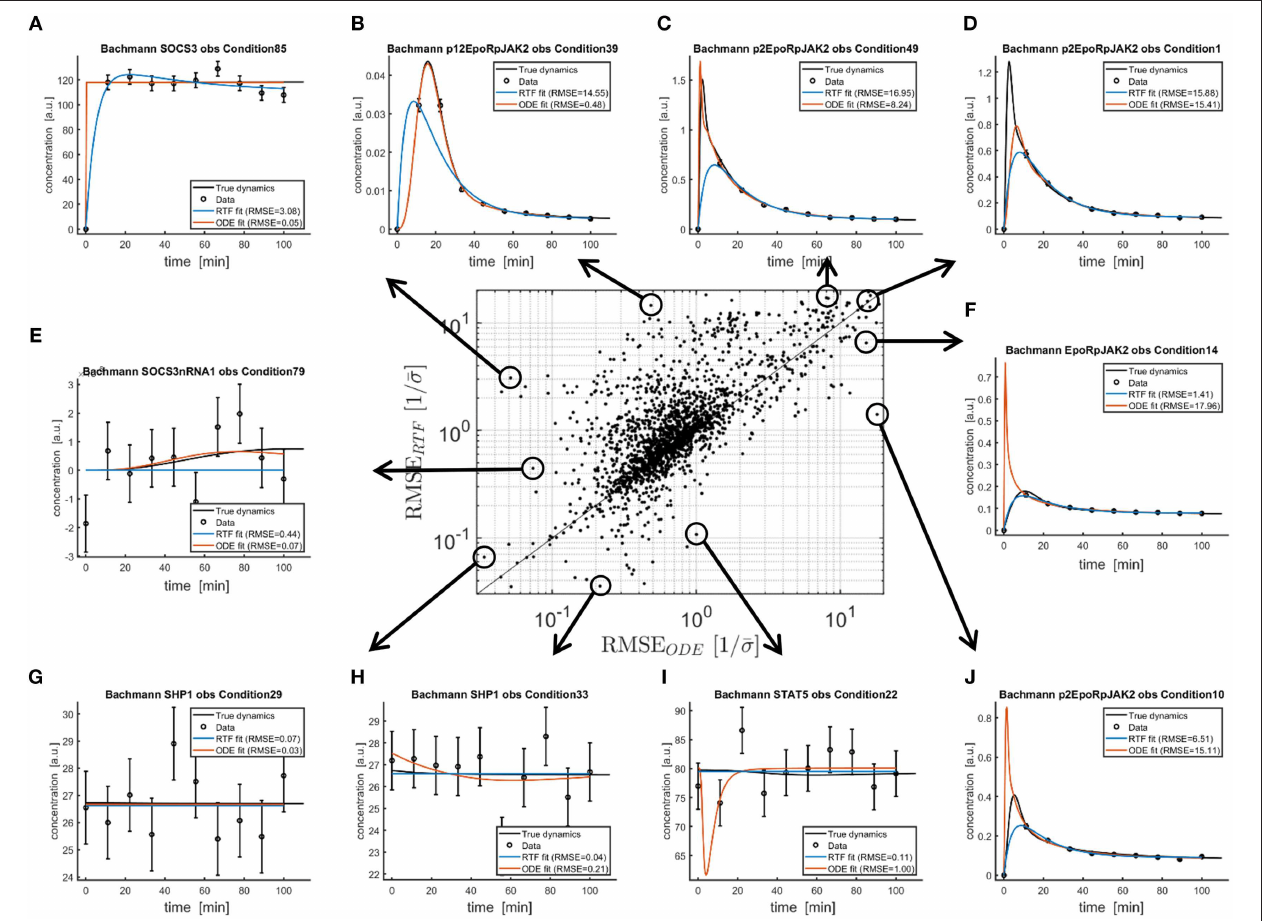
FIGURE 4 | Comparison of both, the fitted RTFs (11), (12) and the fitted ODEs from Bachmann et al. [29] to simulated data with published parameter values. Again, fitting has been performed based on (13), (18)–(21). The scatterplot in the middle shows RMSEs (14) between fitted and true dynamics (black lines) for both modeling approaches. For all points above the diagonal, the ODE model outperforms the RTF. However, there are also several examples where the RTF result in smaller RMSEs. Ten fits for extreme scenarios are plotted in (A–J) .